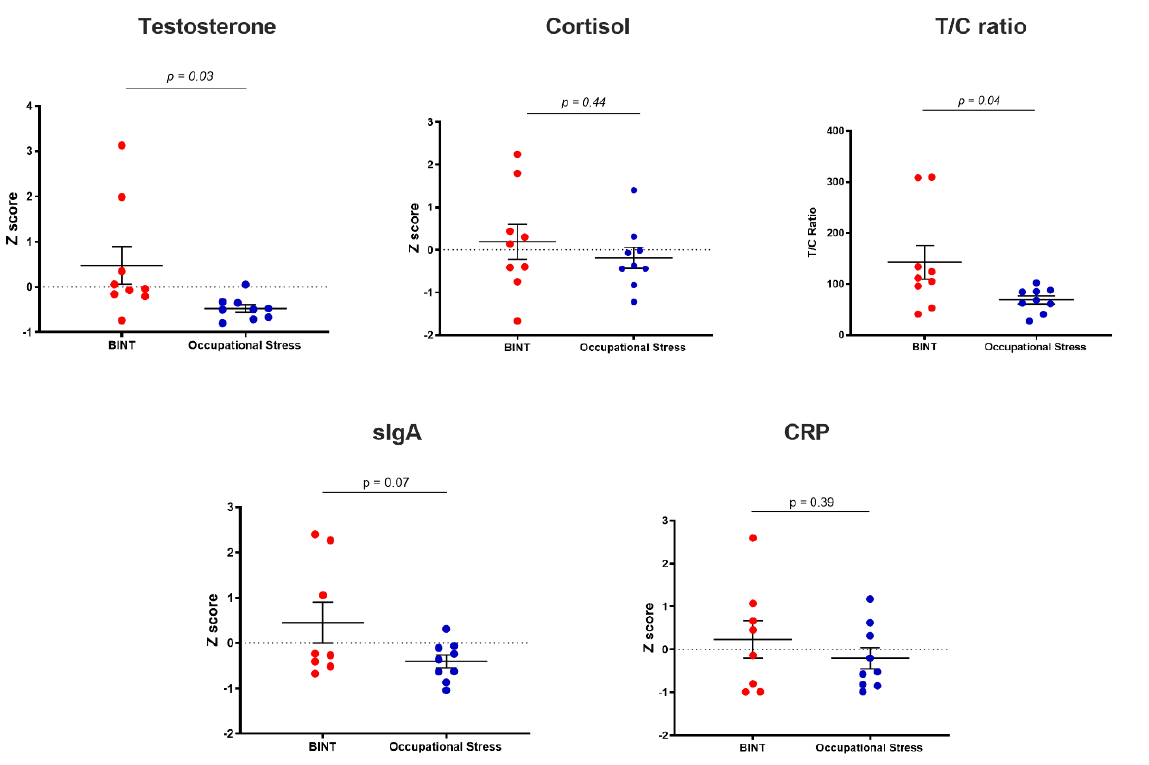
Figure 1. Saliva marker profiles of testosterone, cortisol, testosterone/cortisol (T/C) ratio, soluble immunoglobulin A (SIgA), C-reactive protein (CRP). Data are expressed as mean Z score plus or minus the standard error of the mean (SEM).